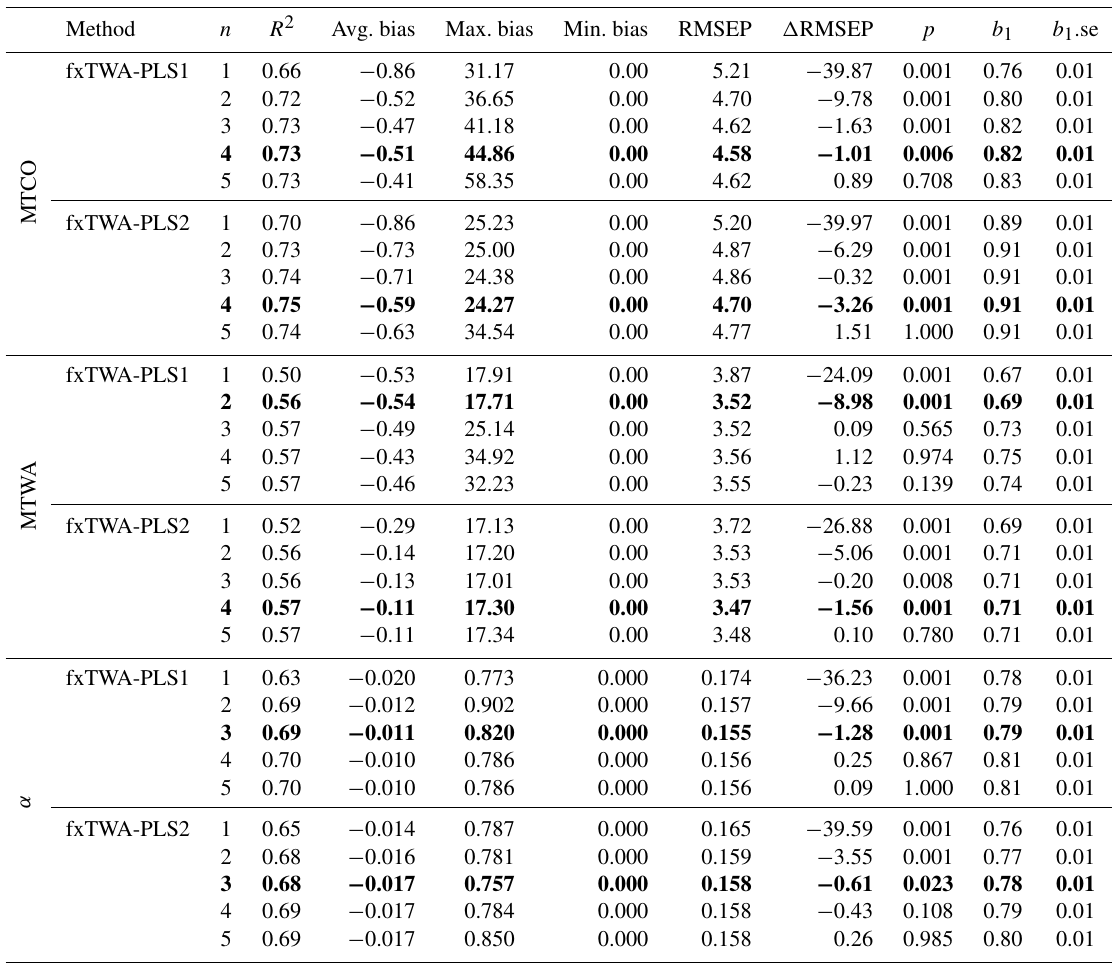
Table A1. Leave-out cross-validation (with geographically and climatically close sites removed) fitness of the previous and modified version of fxTWA-PLS (fxTWA-PLS1 and fxTWA-PLS2, respectively), for the mean temperature of the coldest month (MTCO), mean temperature of the warmest month (MTWA) and plant-available moisture ( α ), using bins of 0.02, 0.02 and 0.002, respectively; n is the number of components used; Avg.bias is the average bias, while Max.bias is the maximum absolute bias and Min.bias is the minimum absolute bias; RMSEP is the root mean square error of prediction; and (cid:49) RMSEP is the per cent change rate of RMSEP, which is (RMSEP n − RMSEP n − 1 ) / RMSEP n − 1 converted into percentage; when n = 1, RMSEP 0 is the RMSEP of null model. p assesses whether using the current number of components is significantly different from using one component less, which is used to choose the last significant number of components (indicated in bold) to avoid overfitting. The degree of overall compression is assessed by doing linear regression to the cross-validation result and the climate variable; b 1 and b 1 .se are the slope and the standard error of the slope, respectively. The closer the slope ( b 1 ) is to 1, the lower the overall compression is. The fx correction is set intrinsically in functions of the fxTWA-PLS package for both versions in this paper, instead of relying on an outside input in Liu et al. (2020), so the values of fxTWA-PLS1 might be slightly different from values in Table 3 of Liu et al. (2020), but it does not affect the